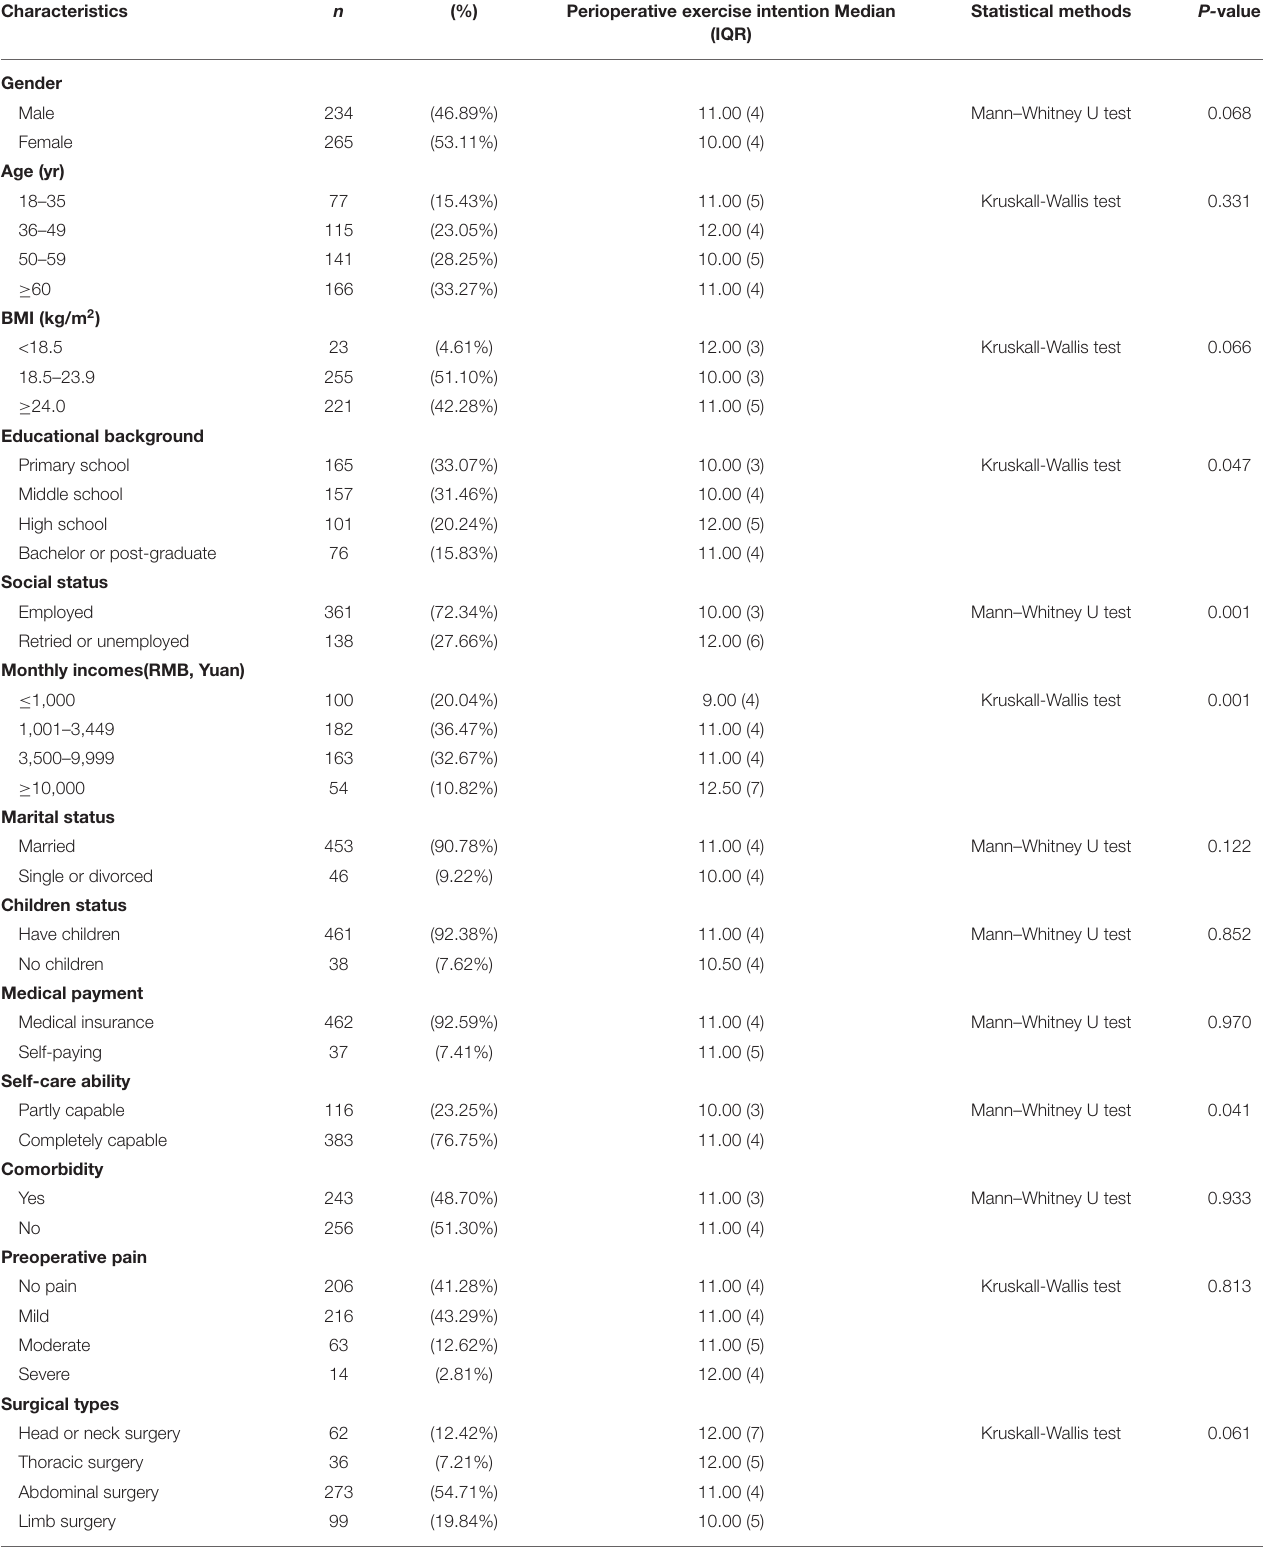
TABLE 1 | Baseline characteristics of survey respondents and factors affecting overall perioperative exercise intention ( N = 499).